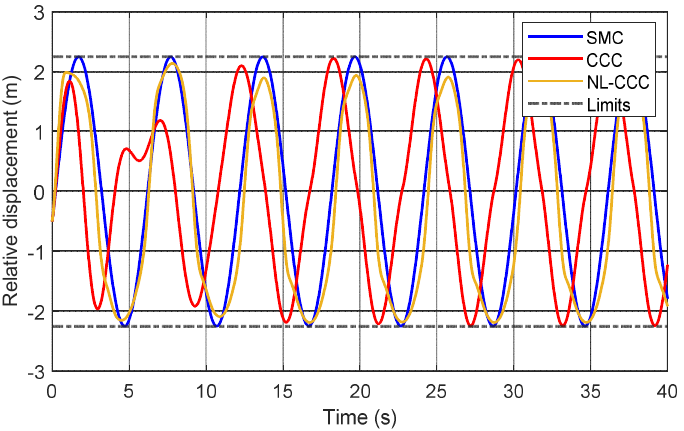
Figure 5. Relative displacement z d ( t ) − η ( t ) of the WEC when implementing SMC, CCC, and NL − CCC at T = 6 s.